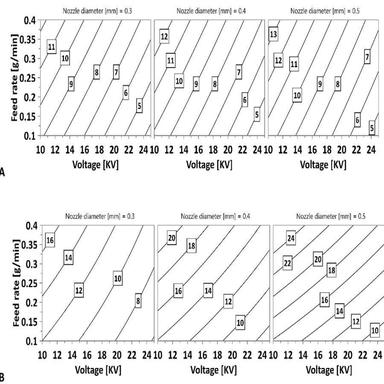
Effects of melt electrospinning parameters on the fibre diameter, μm (A - median; B - IQR).